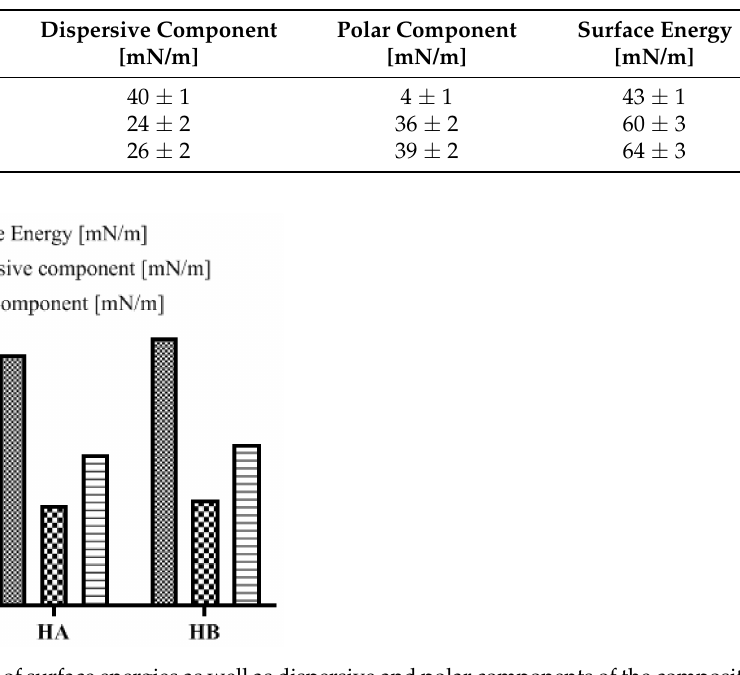
Figure 7. Comparison of surface energies as well as dispersive and polar components of the composites.